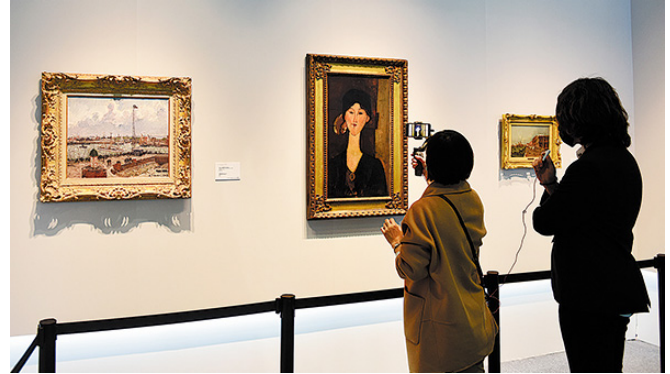
Figure 5. Visitors at the China International Import Expo, Shanghai, November 2021.